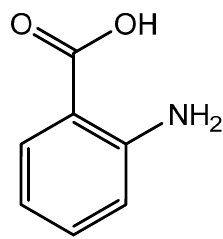
Figure 7. Structural illustration of anthranilic acid.